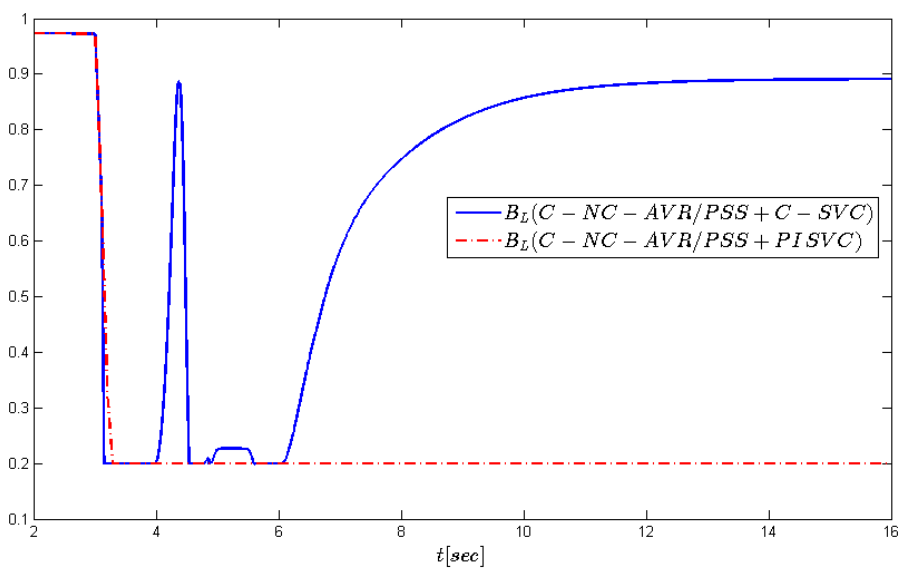
Figure 11. The varying susceptances in the SVC compensator (in p.u.).